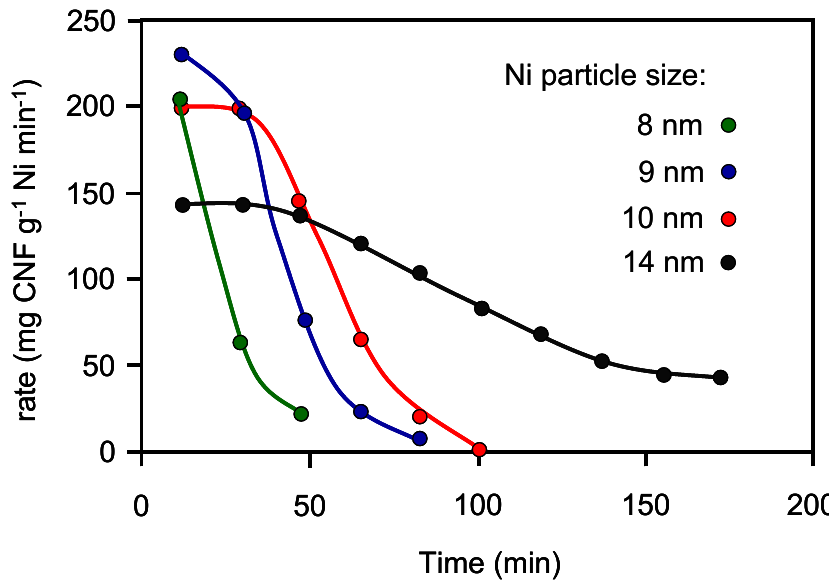
Figure 5. CNF growth rate at 570 ºC as a function of time on stream from a 200 ml min -1 gas mixture containing 50% CH with permission from the Royal Society of